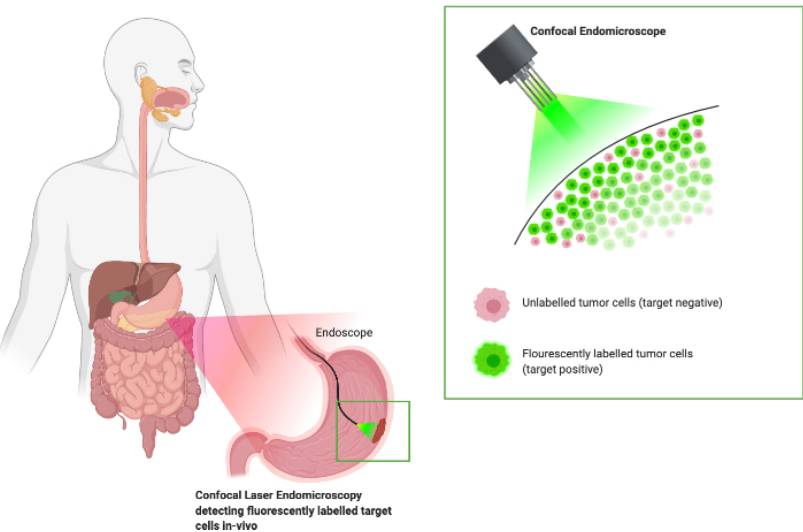
Figure 4. Schematic representation of fluorescent antibody-based confocal laser endomicroscopy for real-time visualization of the extent of the tumor as well as molecular characterization of a suspected neoplastic lesion. Antibodies conjugated with fluorophores (fluorescein, Alexa-flour488, FITC) bind to membrane-associated target proteins expressed in gastric neoplastic tissue (shown in green). The confocal endomicroscope directs light of a specific wavelength (488 nm), thus exciting the fluorochrome and allowing tumor visualization. Confocal images are captured by the endoscope, facilitating in vivo analysis to select patients based on antigen expression patterns.